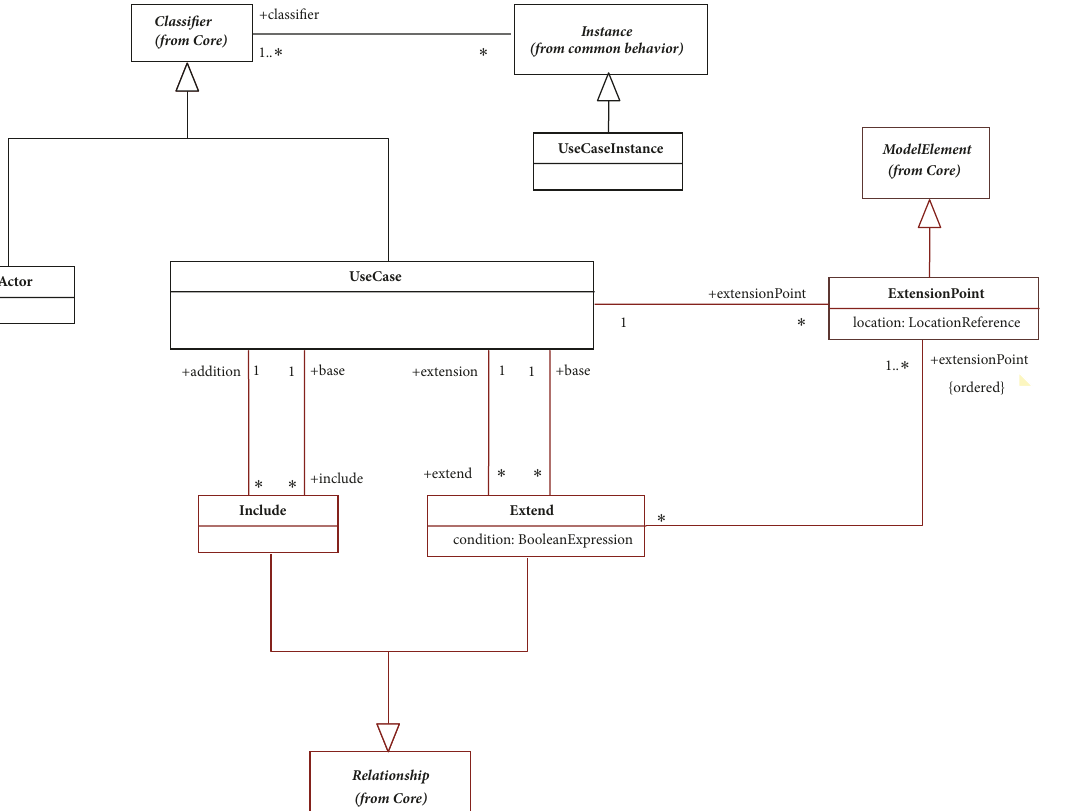
Figure 2: The abstract syntax of use cases